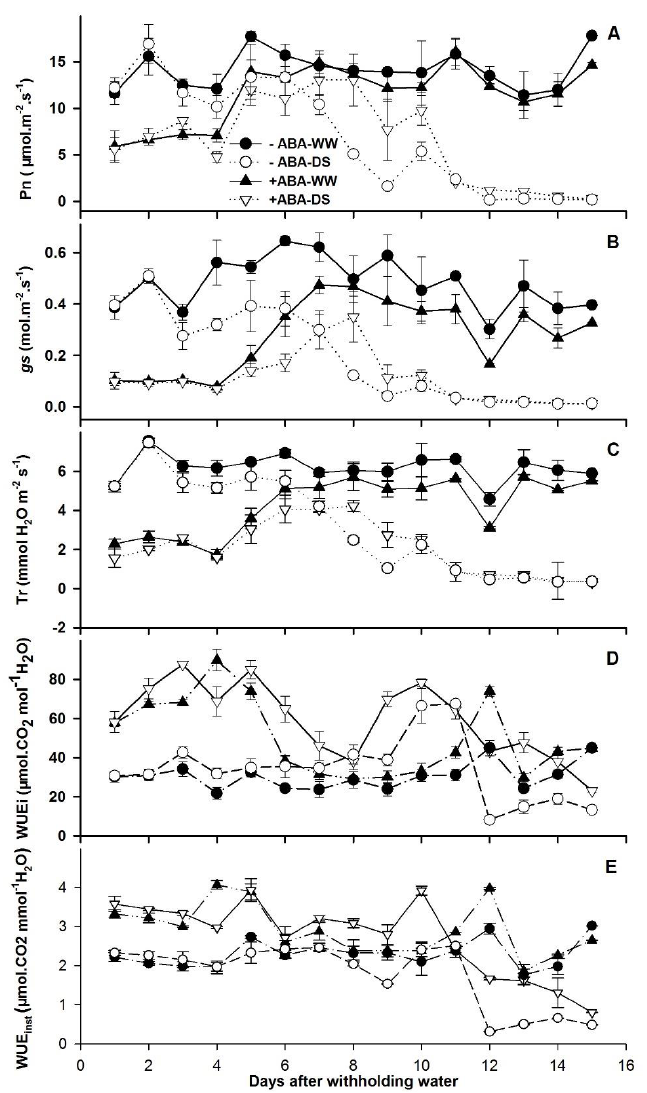
Figure 3. Changes in ( A ) photosynthetic rate (Pn), ( B ) stomatal conductance ( gs ), ( C ) transpiration rate (Tr) and ( D ) intrinsic water use efficiency (Pn/ gs , WUEi) and ( E ) instantaneous WUE (Pn/Tr, WUE inst ) over time (days) after withholding water in the soybean cultivar Jindou 19 (JD). One day before withholding water, plants were pretreated with ( + ABA) or without (–ABA) 10 µ M exogenous ABA. Values are means ± SE ( n =